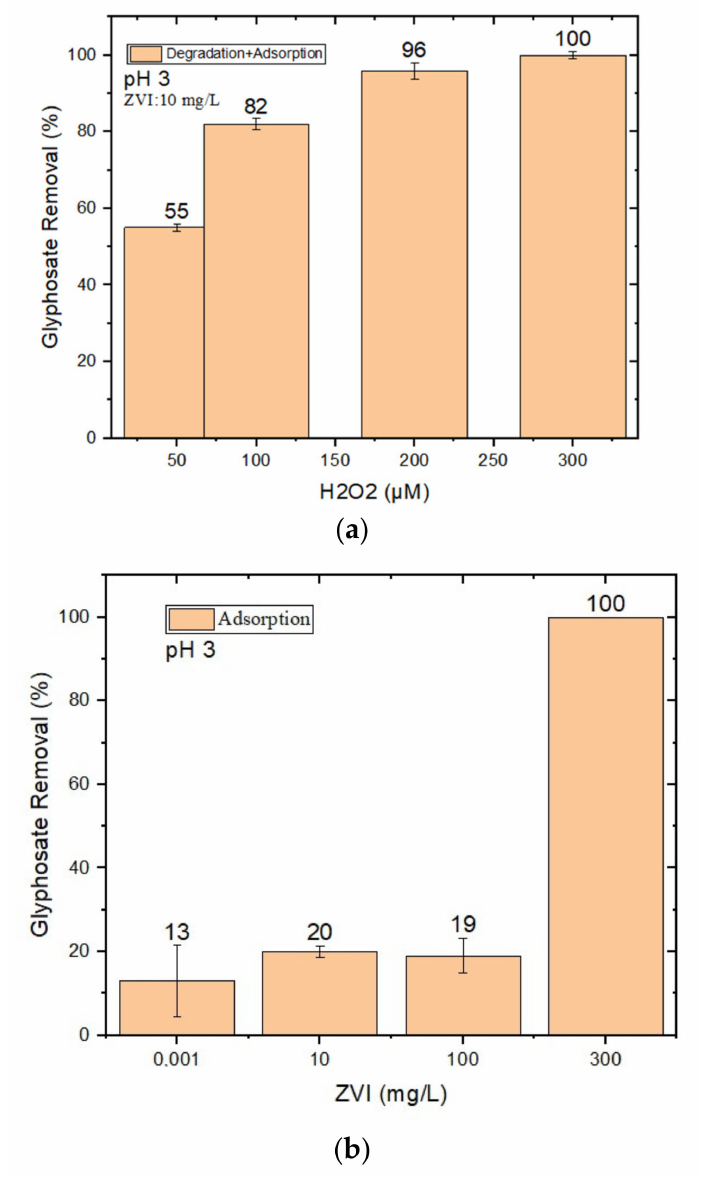
Figure 1. ( a ) Effect of H 2 O 2 concentration (50–300 µ M) on GLY removal via nZVI–Fenton at pH 3 at 10 mg/L nZVI loading, optimized to minimize adsorption; ( b ) GLY removal using different loadings of nZVI alone, without H 2 O 2 , at pH 3. The error bounds represent the standard deviation of triplicate